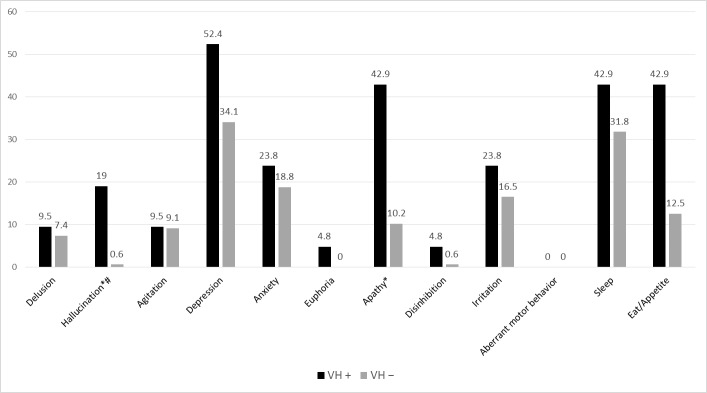
Comparison of frequency of each NPI domain between VH+ and VH− patients.# Hallucination in nonvisual domain. * p < 0.001.